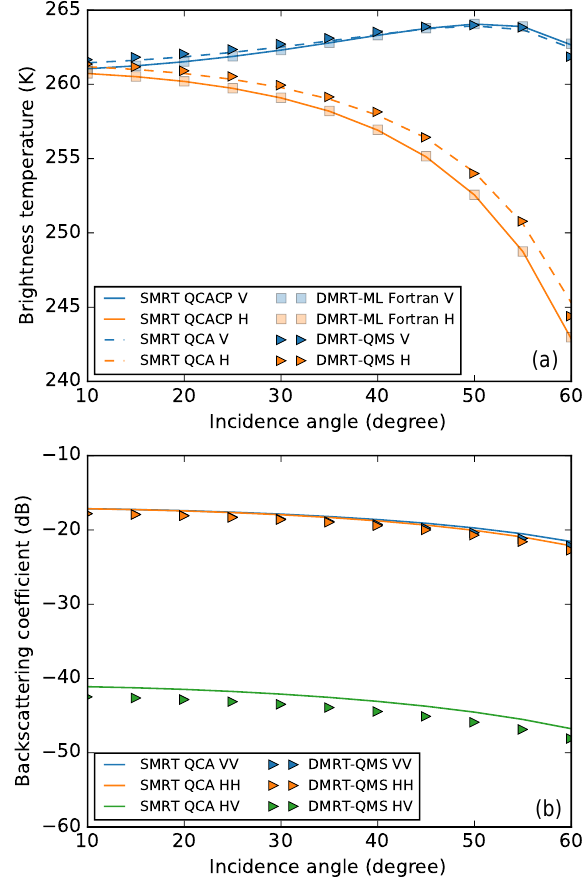
Figure 4. Comparison of brightness temperatures (a) and backscat- tering coefficients (b) simulated by SMRT QCA, SMRT QCA-CP, DMRT-ML, and DMRT-QMS (when relevant for the active mode). The snowpack is semi-infinite with a density of 300kgm − 3 , sphere radius of 100µm, temperature of 265K, and stickiness of 0.5. The frequency is